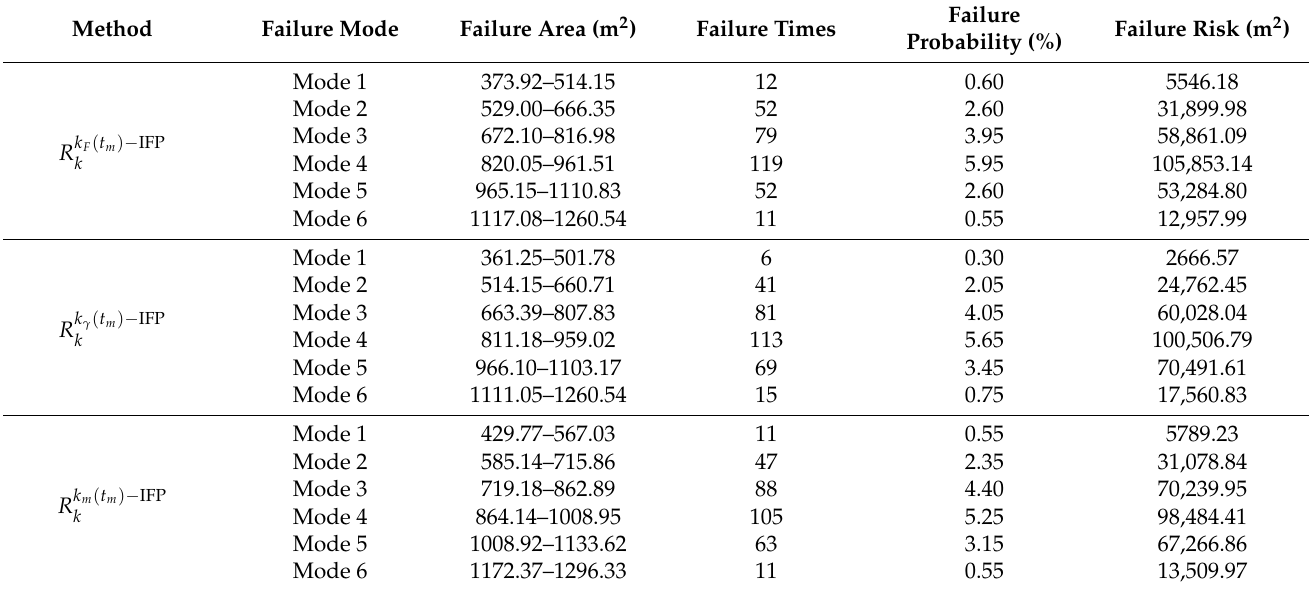
Figure 13. Histogram of s Heterogeneous lope failure area. Table 7. Statistics of heterogeneous slope failure modes.